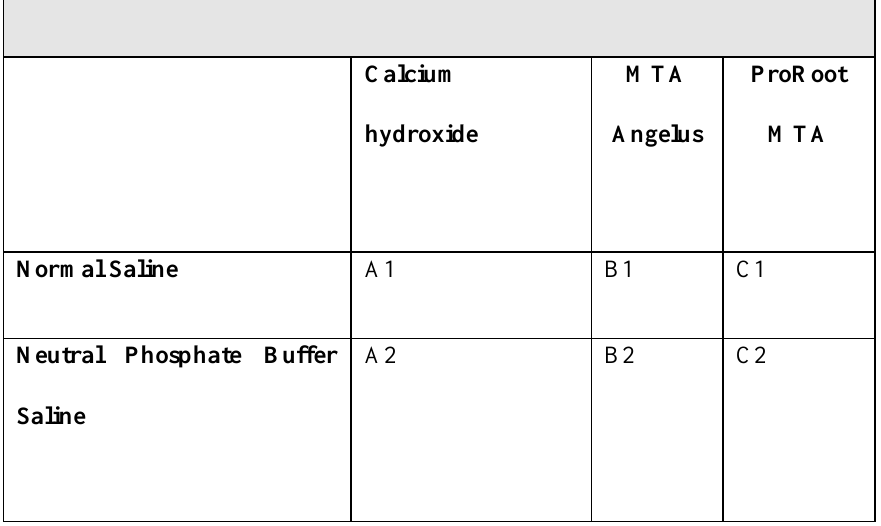
Table 2: Subgroups of the